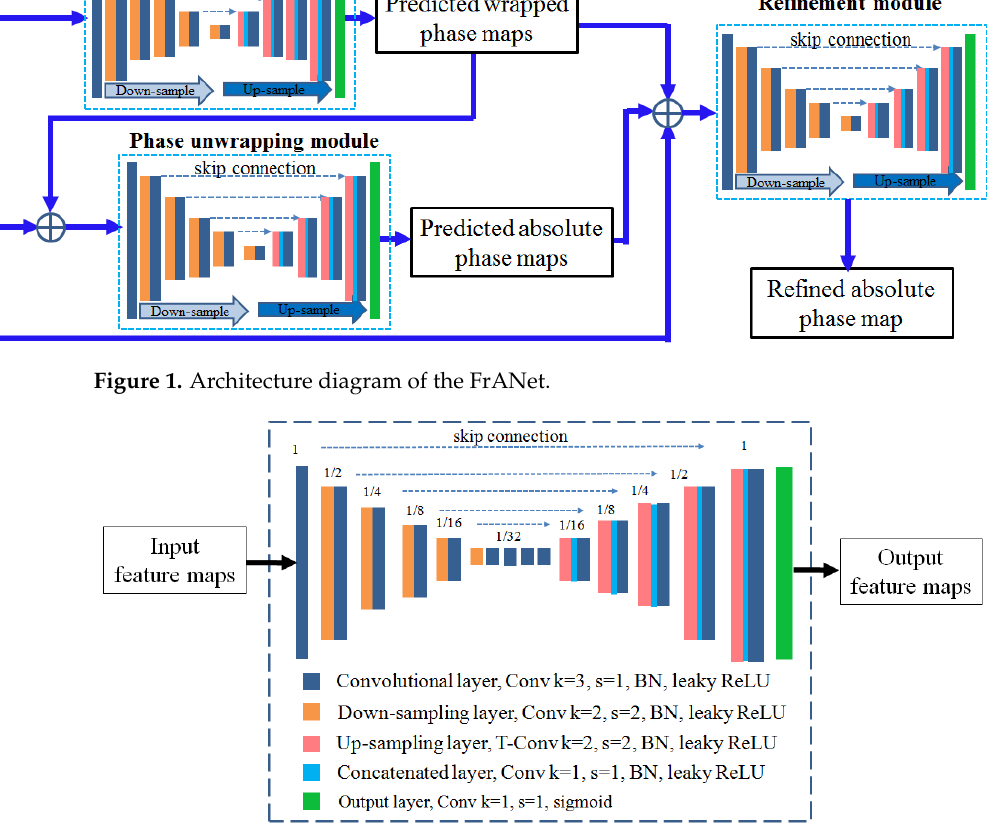
Figure 2. Improved U-Net architecture used in the FrANet.